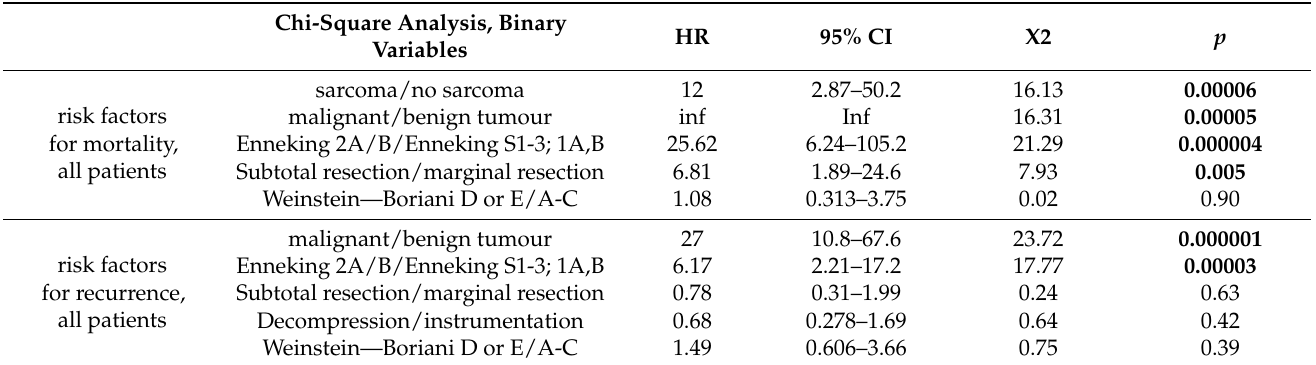
Table 1. Chi-square analysis of binary variables analyzing risk factors for mortality and recurrence for all patients.